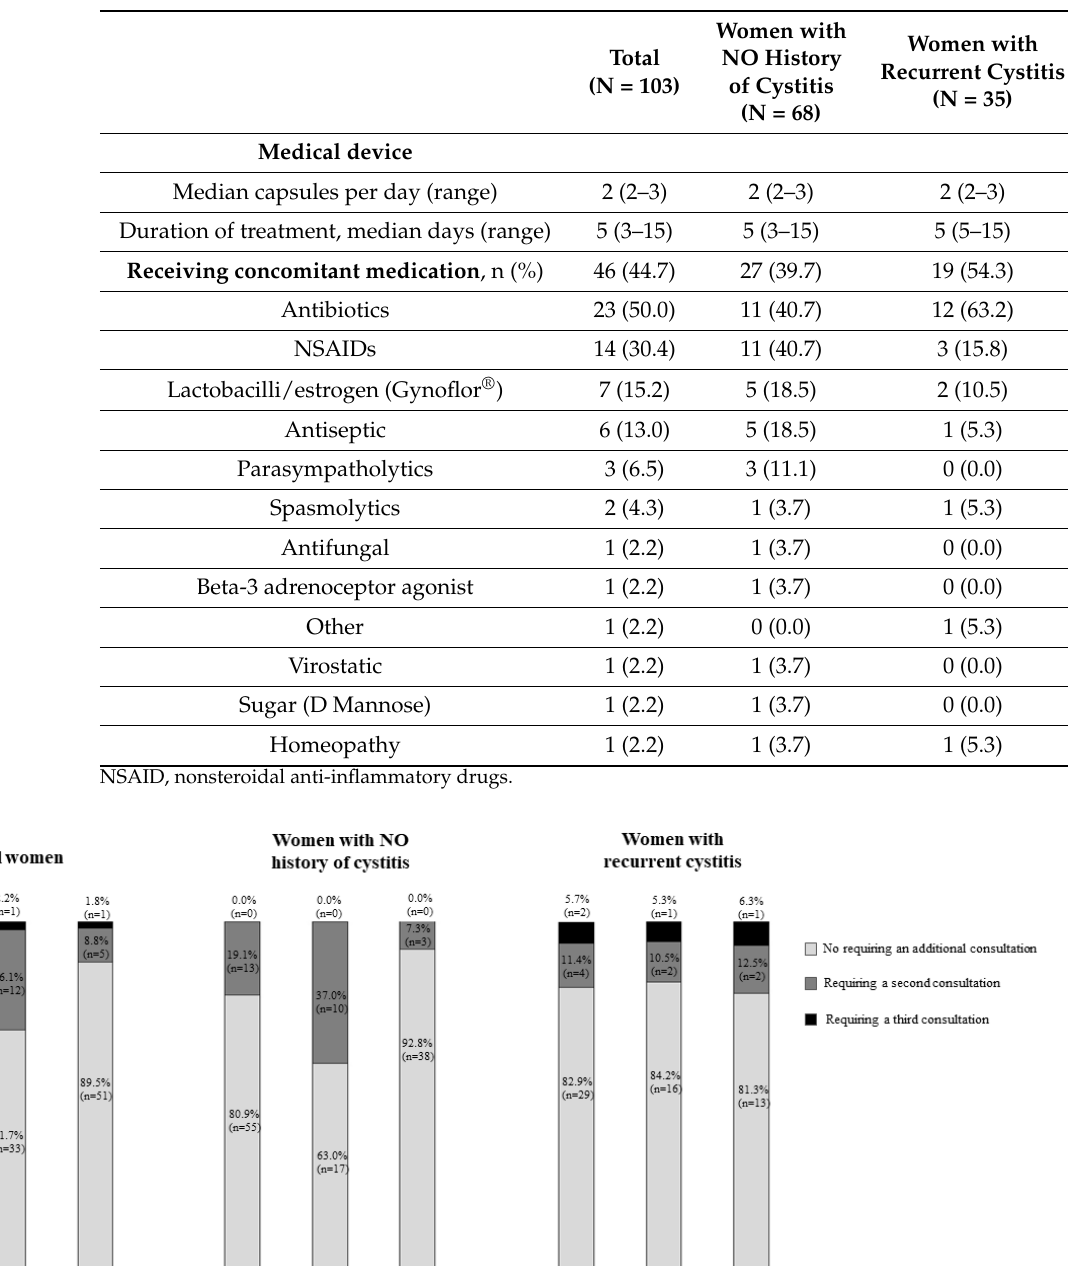
Table 3. Therapeutic management of the episode of acute uncomplicated cystitis.